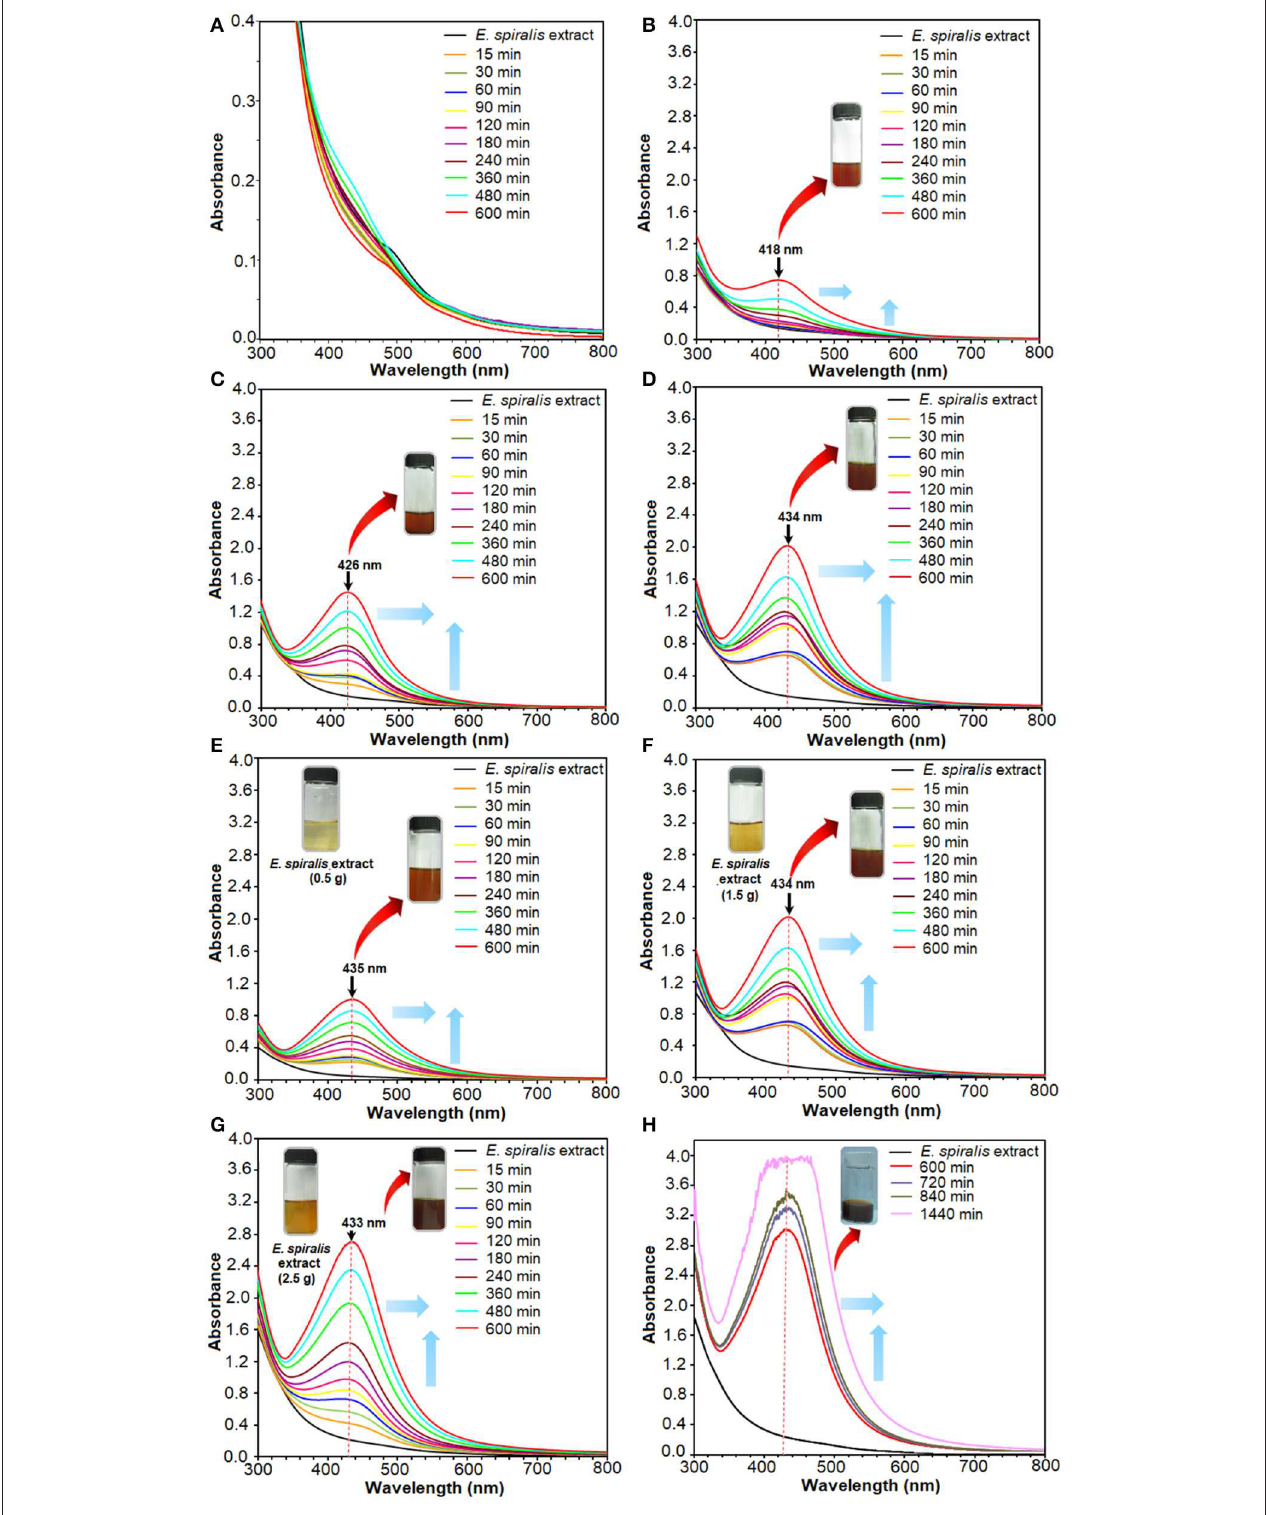
FIGURE 2 | The UV-vis spectra of E. spiralis /Ag-NPs after the reaction at different initial concentrations of 0.005, 0.010, 0.050, and 0.100M AgNO 3 (A–D) , E. spiralis dosage of 0.5, 1.5, and 2.5g (E–G) , and stirring reaction times (H) .